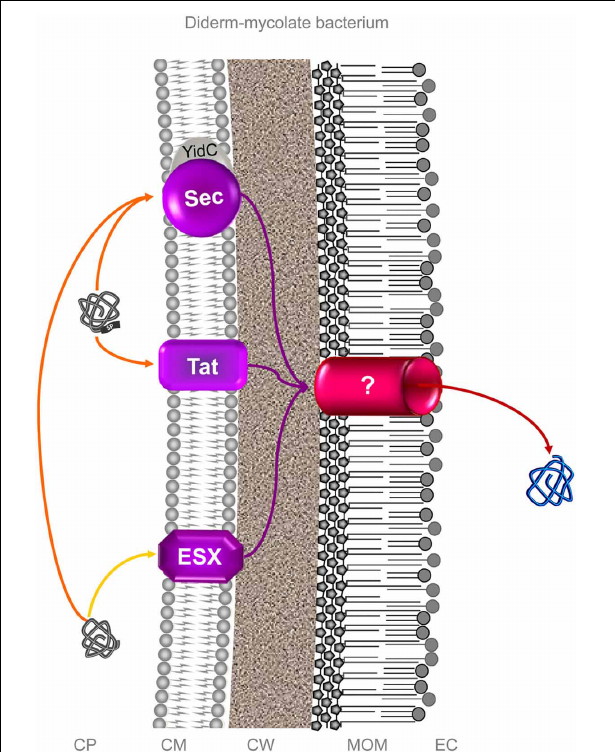
FIGURE 4 | Protein secretion in diderm-mycolate bacteria. In diderm-mycolate bacteria, three protein export systems are currently recognized, the Sec, Tat and ESX (ESAT-6 system) (Digiuseppe Champion and Cox, 2007; Feltcher et al., 2010; Ligon et al., 2012). So far, none have been clearly reported and characterized as involved in surface colonization process. As in monodermata, some proteins with no N-terminal SP can be translocated via Sec in a SecA2-dependent manner (Feltcher and Braunstein, 2012). While it is clear some exported proteins (i.e., first translocated across the CM by these export systems) are further secreted into the extracellular milieu (i.e., translocated across the MOM), no mycomembrane machinery allowing the translocation across the MOM have been identified to date (Niederweis et al., 2010; Houben et al., 2012; Ligon et al., 2012; Freudl, 2013; Van Der Woude et al., 2013). In other no words ( Table 1 ), no protein secretion system has been sensu stricto identified as yet in diderm-mycolate bacteria. It is still an enigma whether one MOM translocon or specific translocons for each of the three protein export systems are present or if the protein secretion is completed in a one-step or two-steps process (Desvaux et al., 2009a). This (or those) MOM translocon would truly correspond to a protein secretion system. For these different reasons and others, numbering the ESX (as “Type VII secretion system”) in diderm-mycolate bacteria is clearly premature and misleading (Desvaux et al., 2009a,b). Orange and yellow arrows indicate the routes of proteins targeted to the CM possessing or lacking an N-terminal SP. Violet arrows indicate the routes for exported proteins and red arrows for secreted proteins. CP, cytoplasm; CM, cytoplasmic membrane; CW, cell wall; MOM, mycolate outer membrane (or mycomembrane); EC, extracellular milieu; SP, signal peptide.